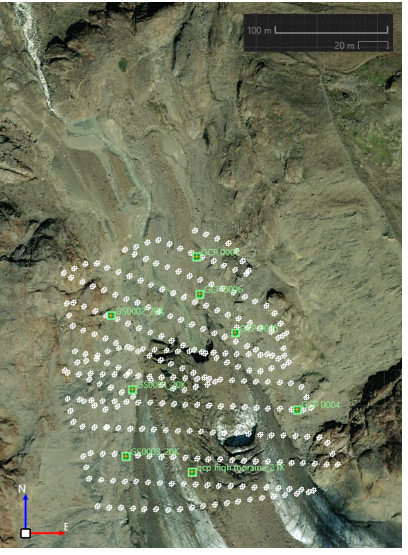
Figure 5. UAV tracks and target distribution - 2020 block.